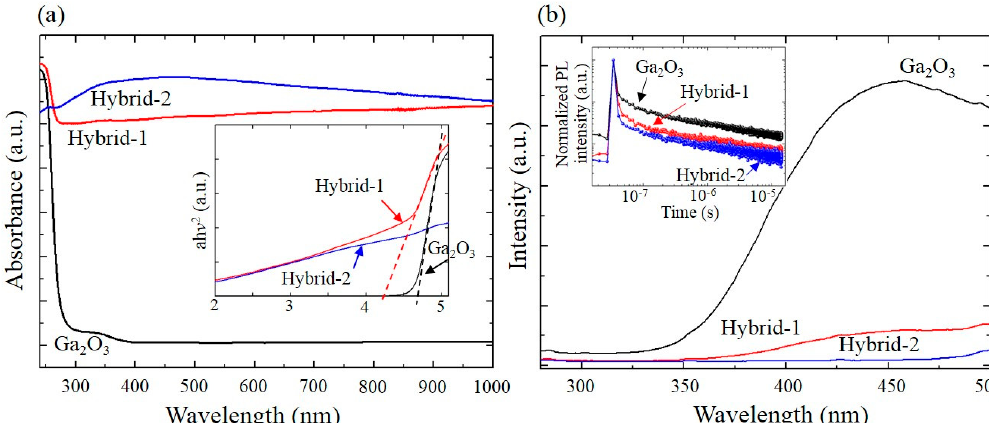
Figure 3. ( a ) UV-Vis-NIR spectroscopy and ( b ) PL spectroscopy of Ga 2 O 3 and Ga 2 O 3 -rGO hybrids at room temperature. The inset in Figure 3a shows a Tauc plot, which is one method of extracting an optical energy bandgap in semiconductors. The inset in Figure 3b shows the normalized PL decay of the Ga 2 O 3 and Ga 2 O 3 -rGO hybrids, which was measured at the emission wavelengths of 455 nm and 459 nm, respectively. Table 1. Summary of the fitting parameters for the PL decay components of the Ga 2 O 3 and hybrids. A A 1 τ 1 (ns)